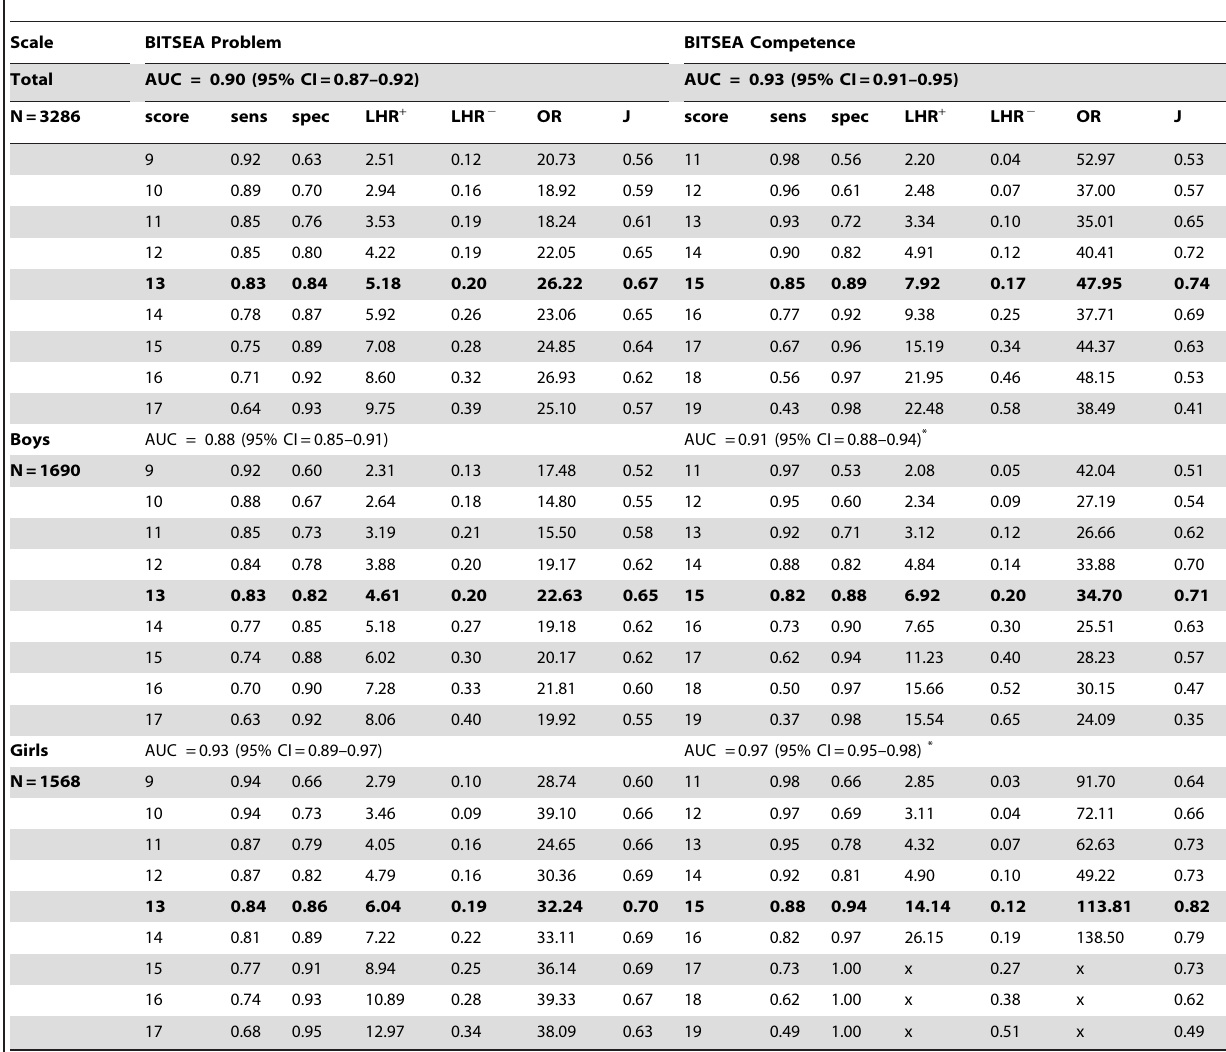
Table 2. The screening accuracy of the BITSEA scales with regard to autism spectrum disorders: Area Under the Curve and sensitivity, specificity, liklihood ratio’s, diagnostic odd ratio and Youden’s index for a range of Problem and Competence scores, for the total sample and for subgroups by